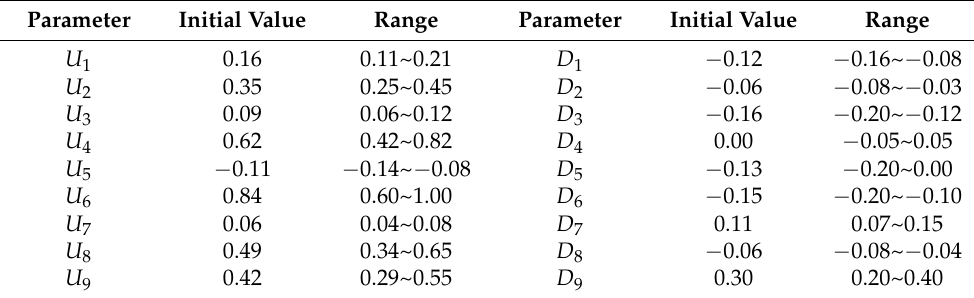
Table 2. Optimized parameter settings.